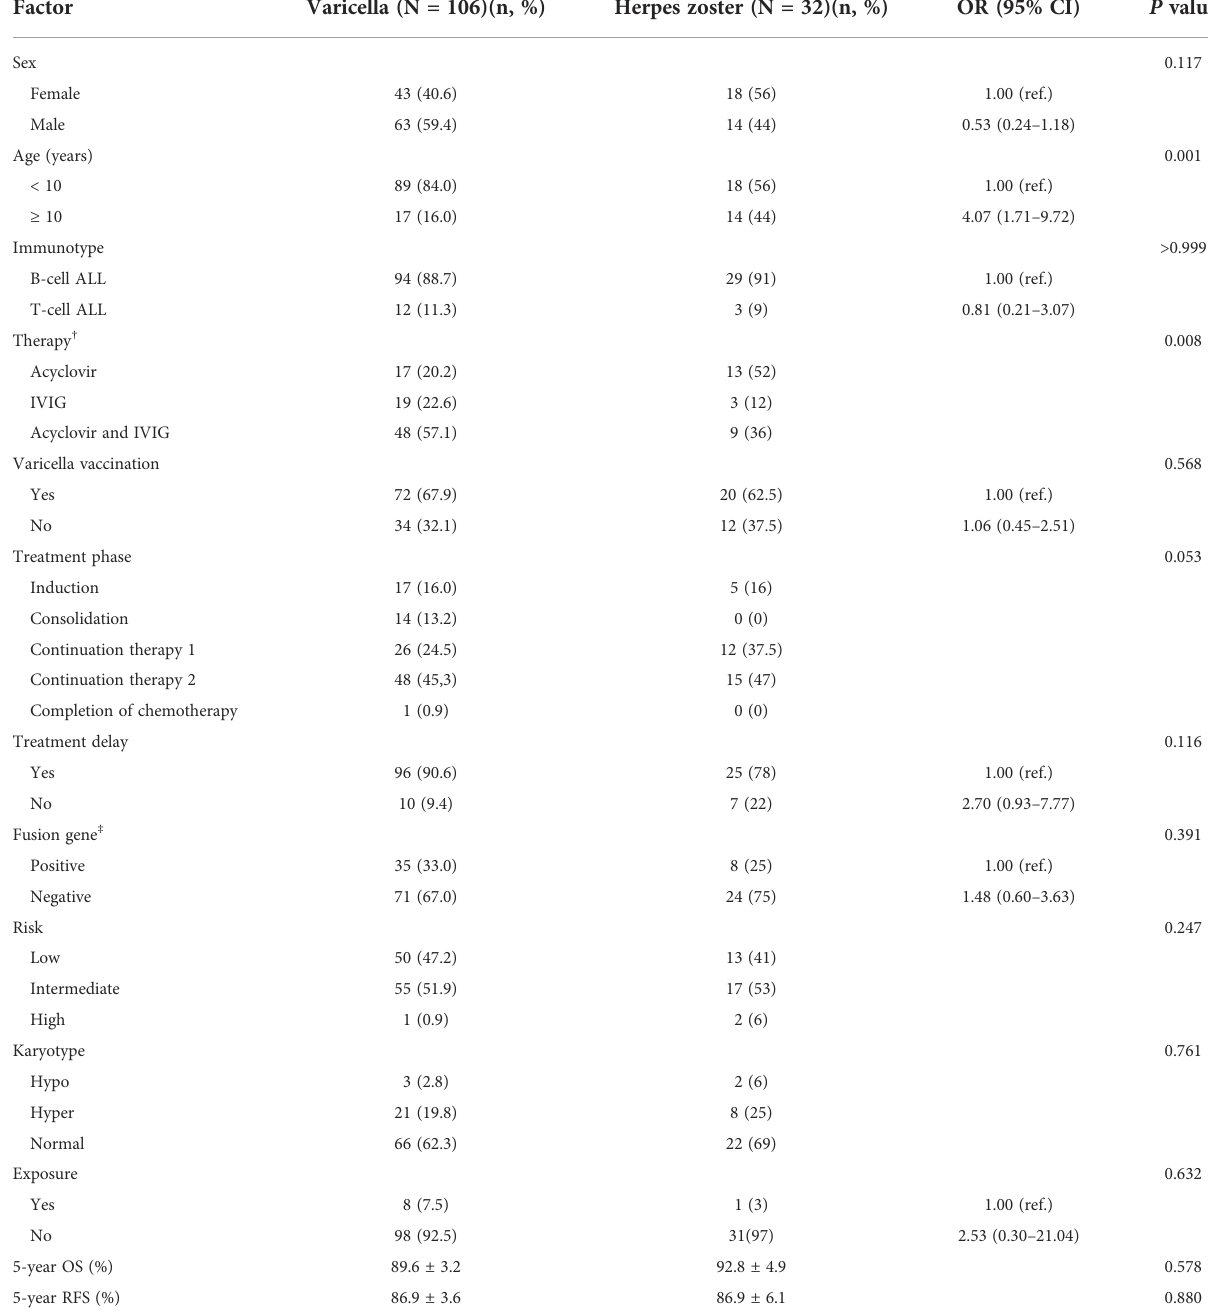
TABLE 3 Characteristics of children with acute lymphoblastic leukemia and varicella or herpes zoster.